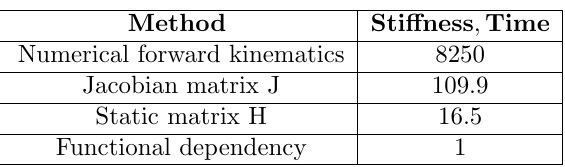
Table 3: Static stiffness computation time for four dif- ferent